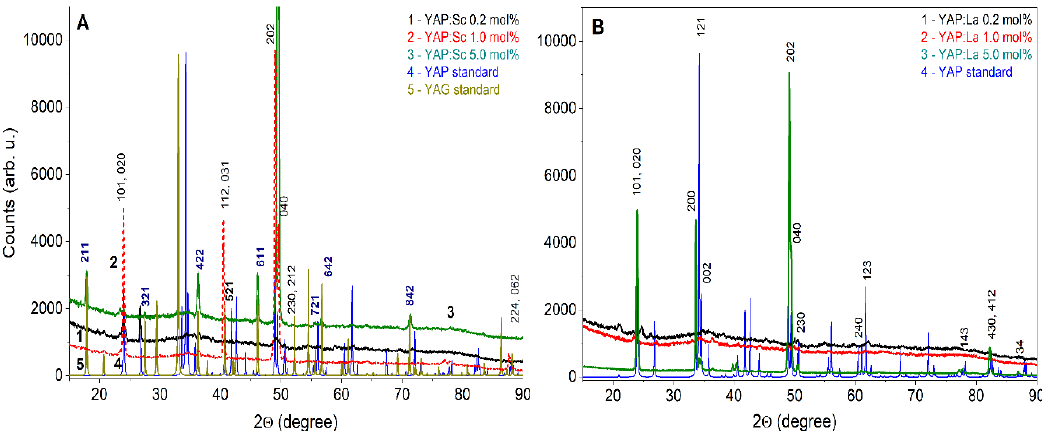
Figure 1. The X-ray diffraction (XRD) patterns of YAlO 3 (YAP):Sc ( A ) and YAP:La ( B ) crystals with different dopant concentrations in comparison with YAP (A, B) and yttrium aluminum garnet (YAG) (A) standards.